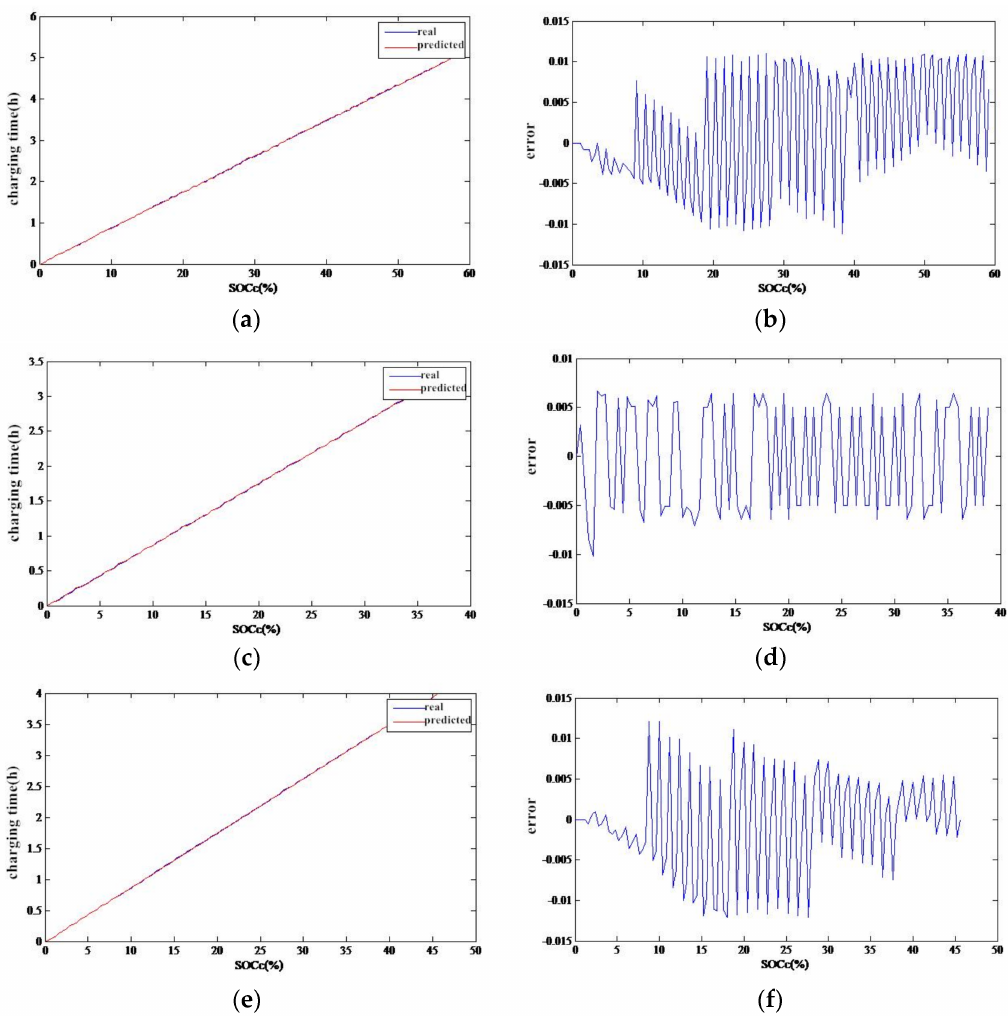
Figure 7. Prediction results and errors of the prediction combined model of charging time. ( a ) Prediction of charging time of data 1; ( b ) charging time prediction error of data 1; ( c ) prediction of charging time of data 2; ( d ) charging time prediction error of data 2; ( e ) Prediction of charging time of data 3; ( f ) charging time prediction error of data 3.